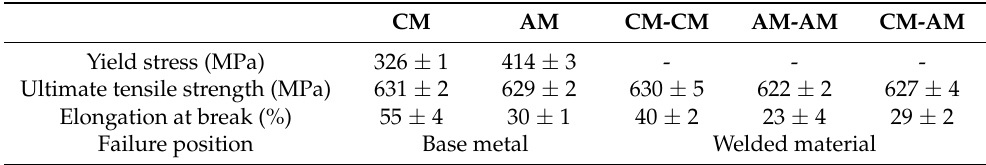
Table 7. Tensile test results of reference and welded samples.